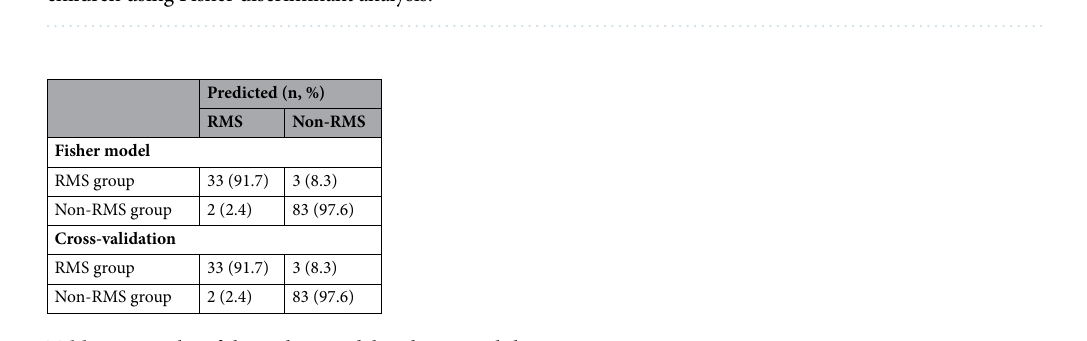
Table 2. Results of the Fisher model and cross-validation.